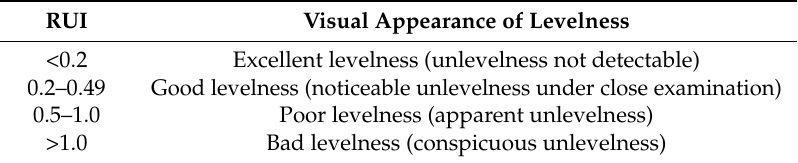
Table 4. Suggested interpretation of the relative unlevelness index (RUI) values (Chong et al.)